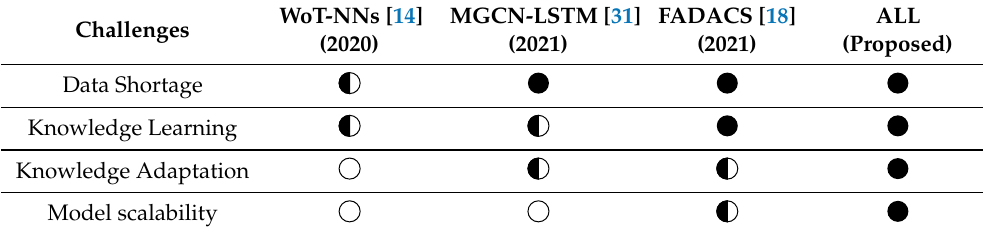
Table 1. Challenges and representative solutions in small-sample POP ( : Solved; : Partially; :